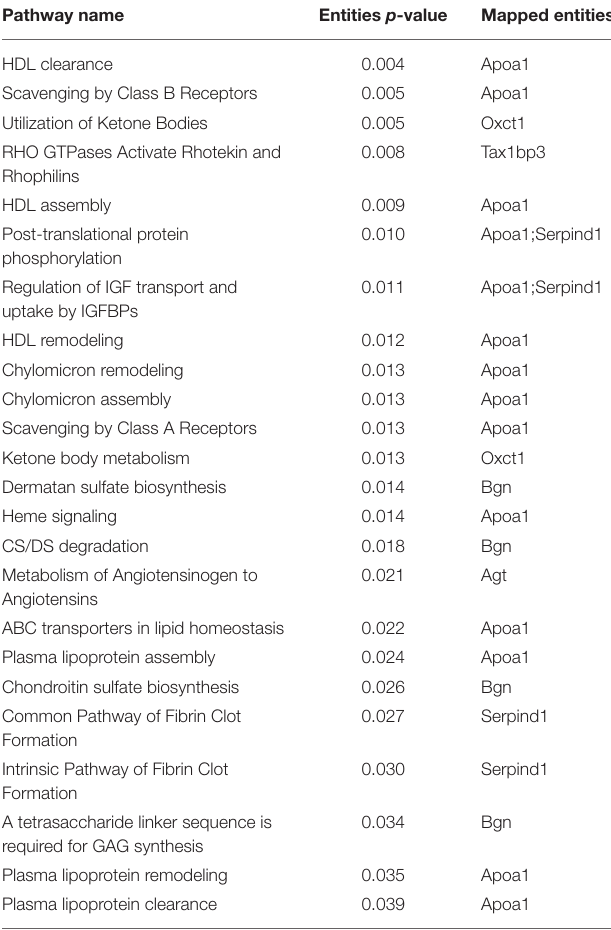
TABLE 1B | Top pathways associated with upregulated proteins (listed in Table 1A ) altered with